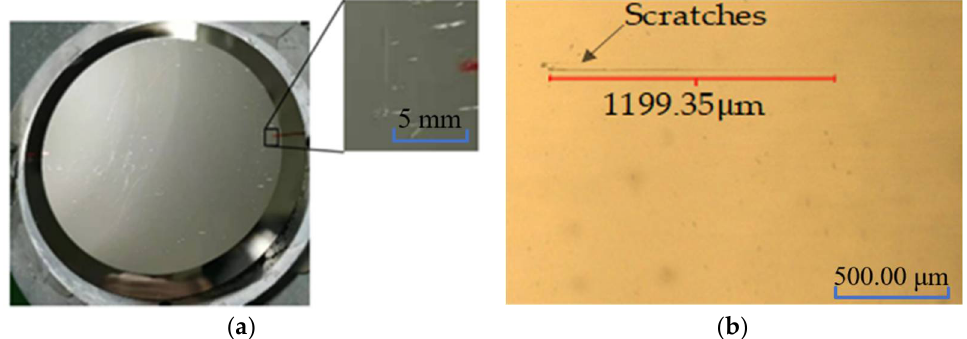
Figure 2. Scratch phenomenon. ( a ) Scratch phenomenon. ( b ) Scratches measured by a microscope.